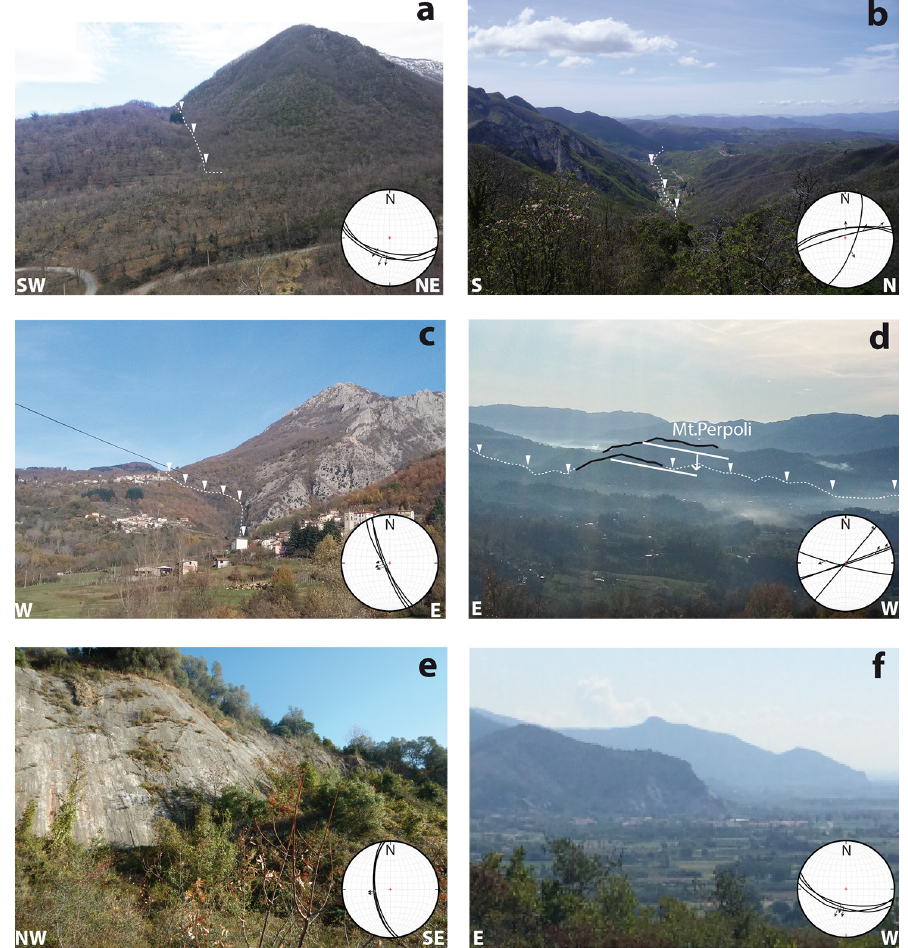
Figure 6. ( a ) Panoramic view (toward N/NW) of the Compione Fault (structural domain SD2). ( b ) Panoramic view (toward W/SW) of the Aiola–Equi Terme fault part of the North Apuane Fault System. The village in the valley is Equi Terme, epicentral area of the 2013 Lunigiana earthquake. Photo taken from the road to Ugliancaldo Village, epicentral area of the 1837 Alpi Apuane earthquake; ( c ) Corfino fault in structural domain SD3. ( d ) Monte Perpoli morphostructural high in SD3. White line indicates the base of the Late Pleistocene deposits in the hanging wall and footwall of the North Mt. Perpoli fault. The latter is taken to have produced the 2013 Garfagnana earthquake. ( e ) Pietrasanta fault (SD5), central southern segment of the West Alpi Apuane fault, the major bounding fault of the Viareggio basin. ( f ) Basin and range landscape forming the western boundary of the Pisa plain (southernmost part of the structural domain SD5). Stereonets show microtectonic measurements we made on the faults (minor fault planes and slickenslides) (Schmid net, lower hemisphere).